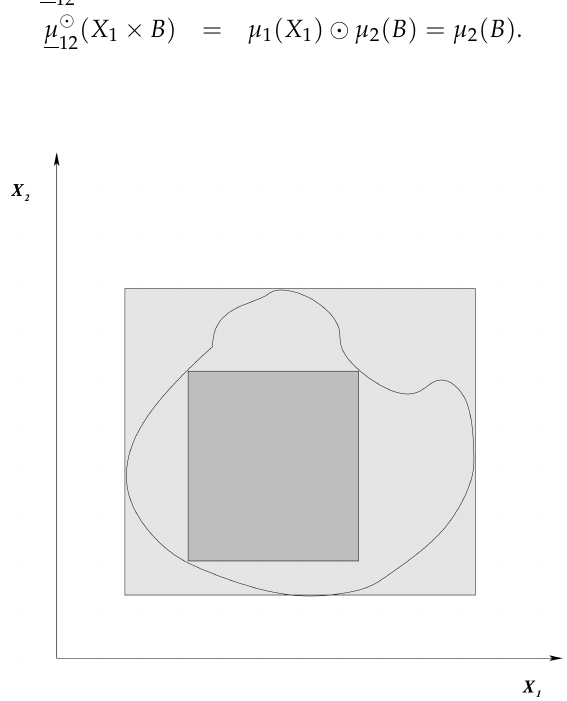
Figure 1. A representation of internal and external product